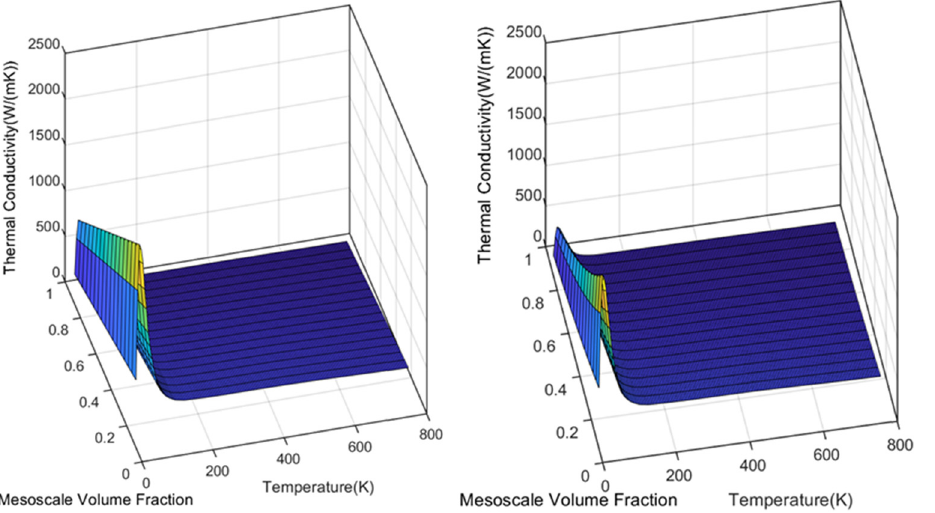
Figure 12: E ff ects of volume fraction of mesoscale homogenized Nb 3 Sn fi lament group and temperature on the global homogenized thermal conductivity, ( Left ) K 11⁎ , ( Right ) K K 22⁎ 33⁎ ( ) . Note: Volume fraction 0.72 is speci fi ed for the microscale homogenized Nb 3 Sn fi lament